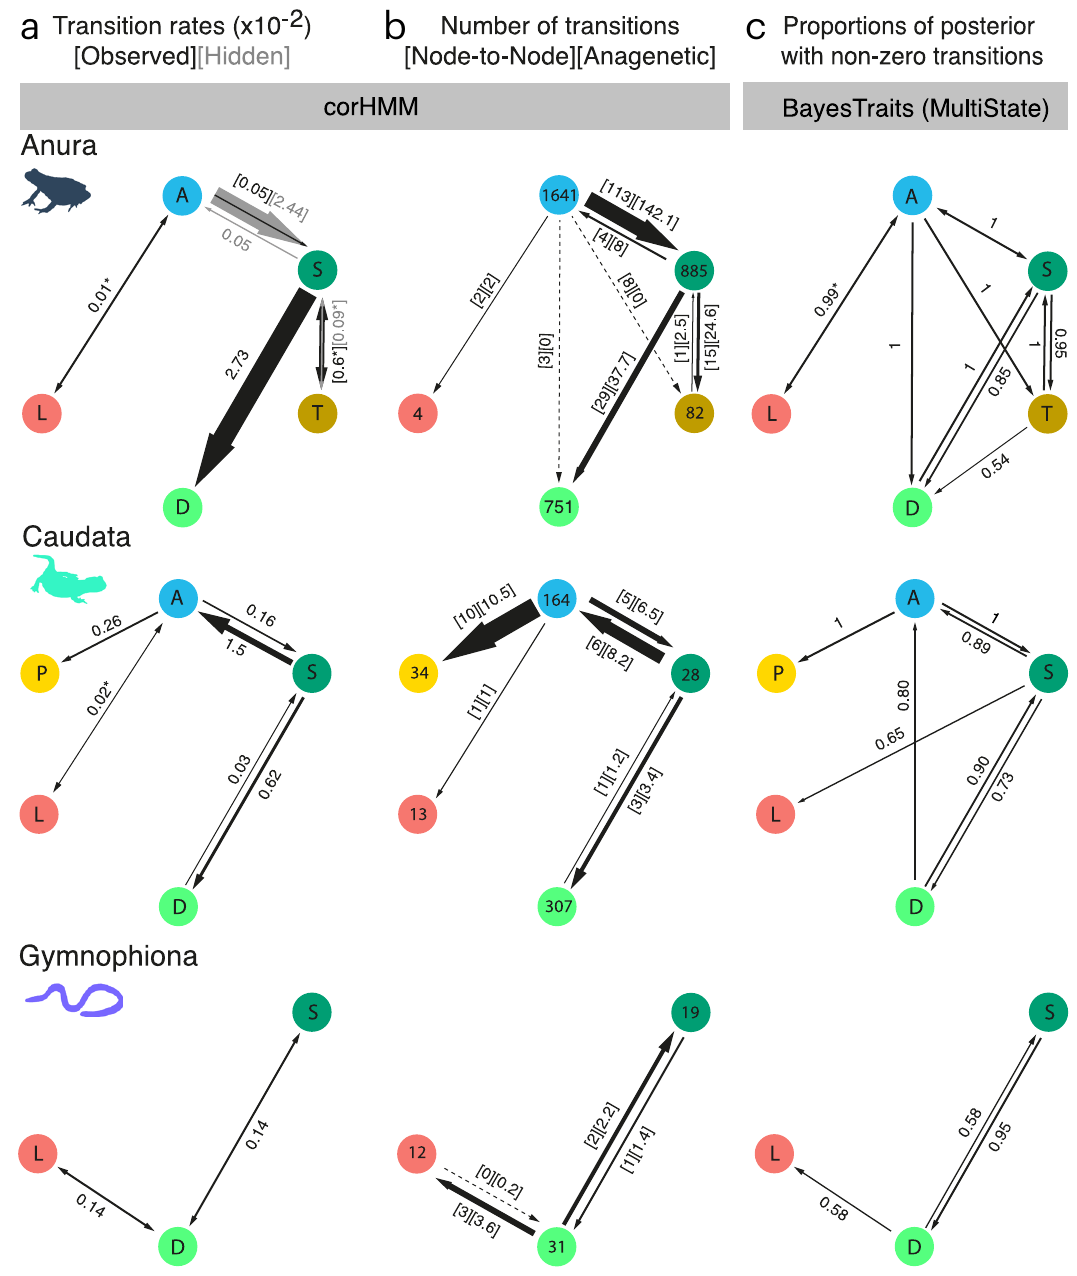
Fig. 3 | Estimated rates, frequencies and posterior sampling of reproductive- mode transitions in each major amphibian group. a Estimated transition rates (×10 − 2 ) from best-performing corHMM models. Gray arrows and annotations representhiddenstaterates.Rateslowerthan0.01arenotshown.Thebestmodels forAnuraandCaudataallowedforallratestobedifferent(exceptforpairsofrates annotatedwithanasterisk thathave been forcedto be symmetrical;see Methods), and the model for Gymnophiona had all rates set to be equal. b Numbers of tran- sitions when estimating ancestral states at nodes only using joint estimations [Node-to-Node]andthemeannumbersoftransitionsalongbranches[Anagenetic], estimated from 1000 stochastic character maps. Dashed lines indicate transitions only recovered using one of the two methods. The number of species per